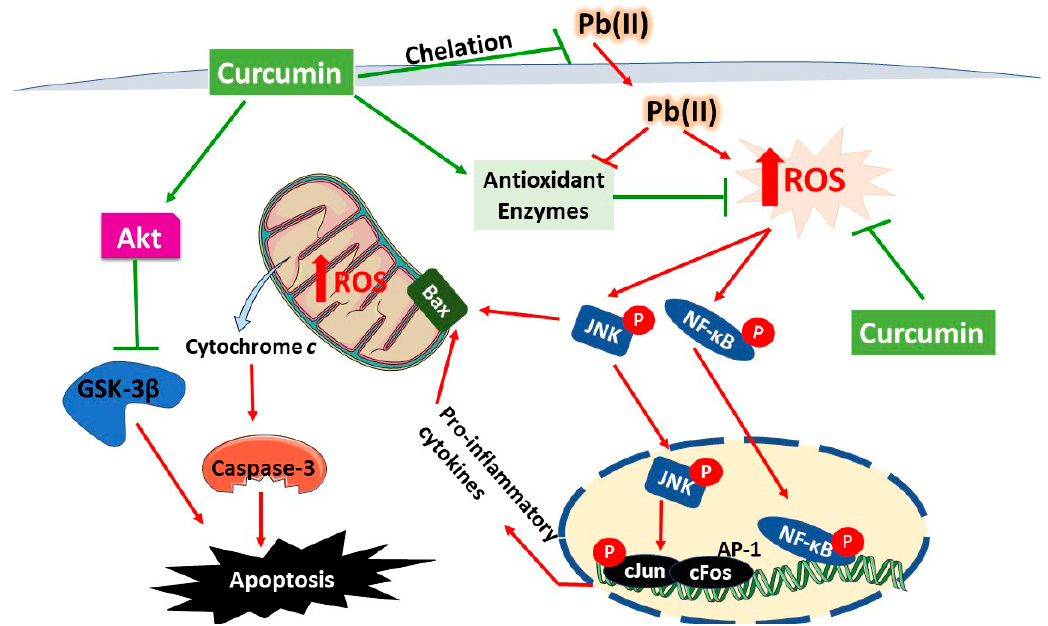
Figure 8. A schematic diagram illustrating the protective mechanism of curcumin against Pb(II) hepatotoxicity. Pb(II) increases ROS generation and activates NF- κ B, JNK and GSK-3 β , resulting in inflammation and cell death via apoptosis. Curcumin suppresses ROS production, chelates Pb(II), boosts antioxidant defenses and activates Akt signaling. Akt deactivates GSK-3 β through phosphorylation at Ser9.